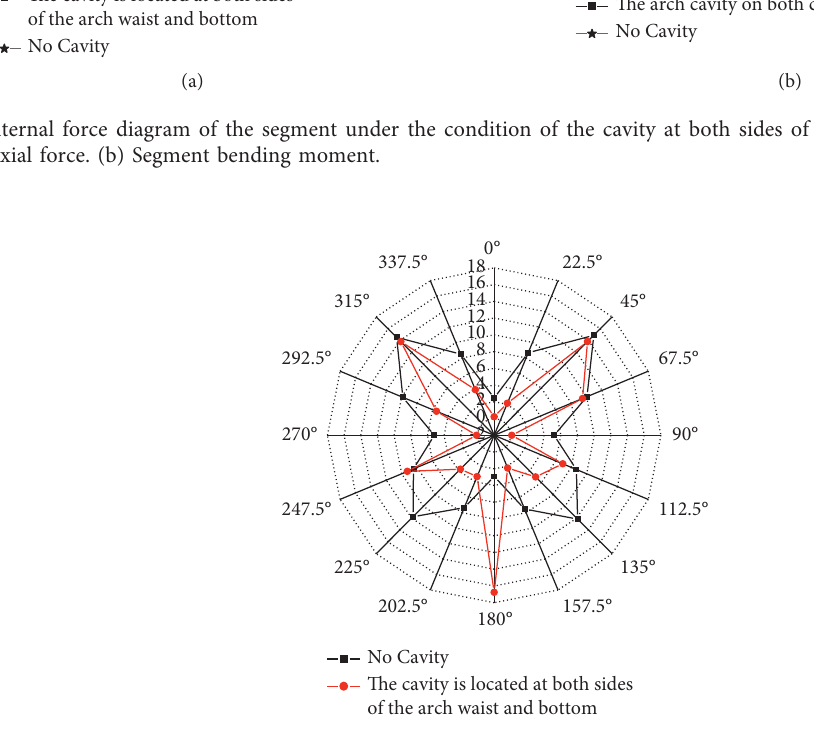
Figure 34: Safety coefficient of the segment cross section under the condition of the cavity at both sides of the arch waist and arch